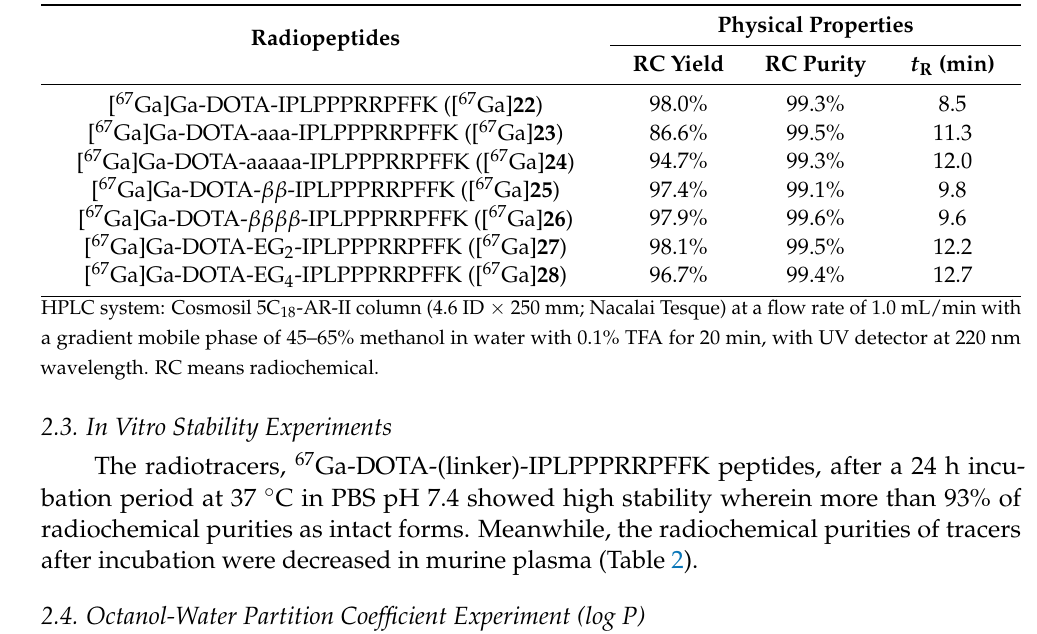
Table 1. Quality control results for [ 67 Ga]Ga-DOTA-(linker)-IPLPPPRRPFFK.